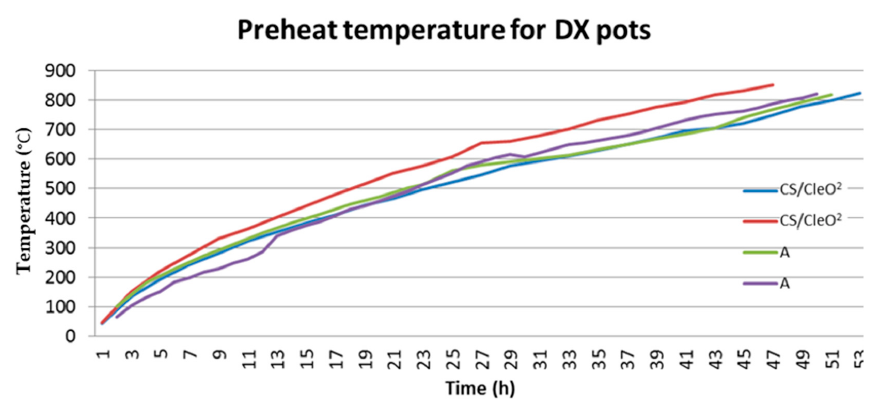
Figure 14. Cleaned DX pot cavity with CleO 2 paste at 369 days.